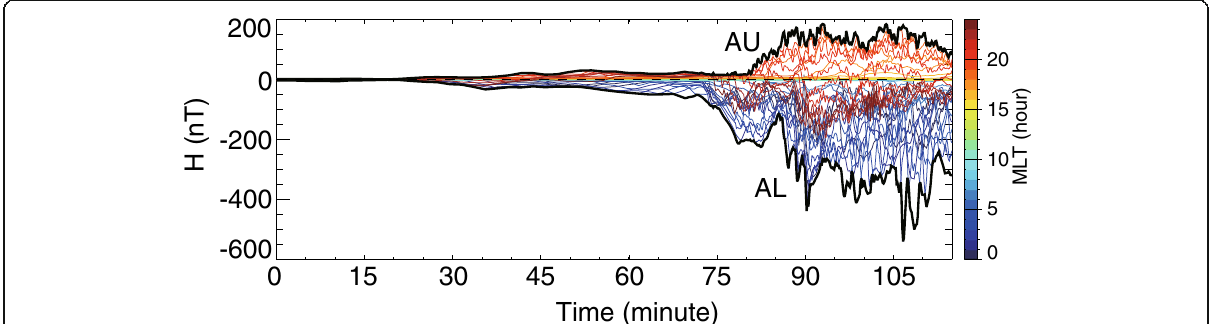
Fig. 1 The H -component of the magnetic disturbance at 70 MLAT and 48 MLTs. The upper and lower envelops are regarded as AU and AL indices,